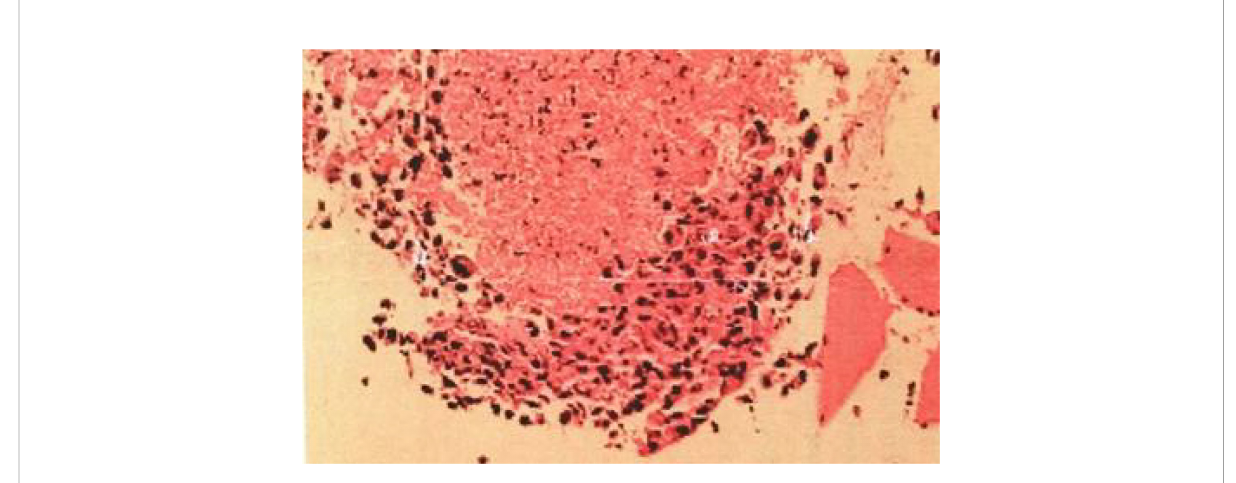
FIGURE 2 Lung tissue sections stained with